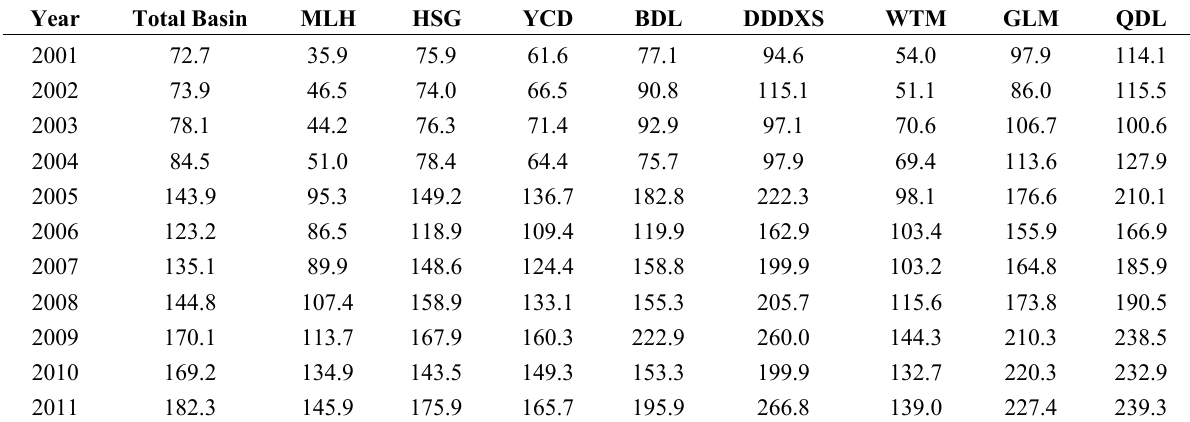
Table 2. Annual SEBS ET 2001 to 2011.